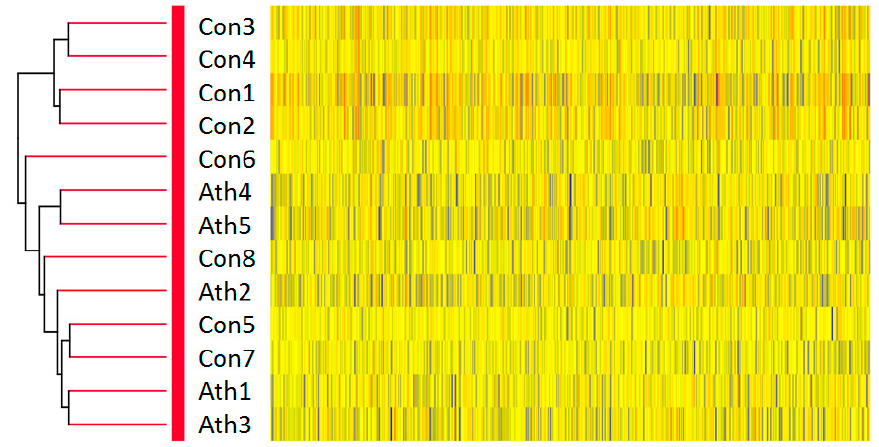
Figure 2. Hierarchical clustering of microarray data in the control and athlete groups. Euclidean distance was used as the metric. The tree was constructed using Ward’s method. Ath1 – Ath5, Endurance athletes ( n = 5); Con1 – Con8 Control subjects ( n = 8).